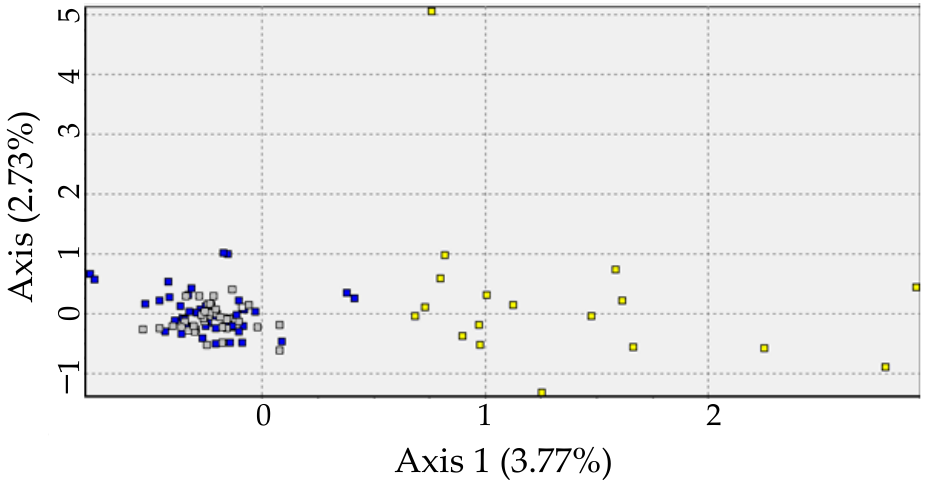
Figure 3. Relationship of the first two axes of the correspondence factor analysis per individual according to the microsatellite markers found in Micropogonias furnieri in Rio de Janeiro state. Yellow squares: North; grey squares: Center; blue squares: South. Table 1. Basic statistics of microsatellite diversity in M. furnieri sampled at three sites at Rio de Janeiro State (Brazil). TNA = Total number of alleles at each loci; N = sampled individuals; NA = number of alleles; HO = Observed heterozygosity; HE = Expected Heterozygosity; HWE= Probabil- ity values of Hardy-Weinberg Equilibrium; FIS= Inbreeding coefficient estimates.